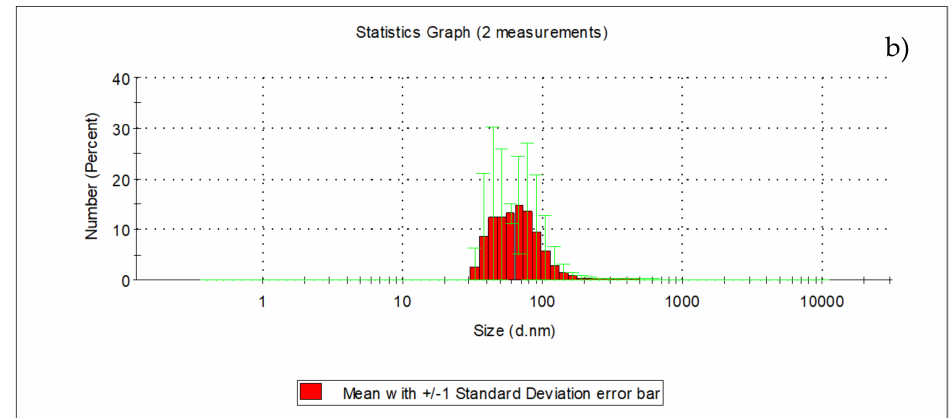
Figure 2. Distribution of particle sizes in surface water before microfilters ( a ) and following microfil- ters ( b ).